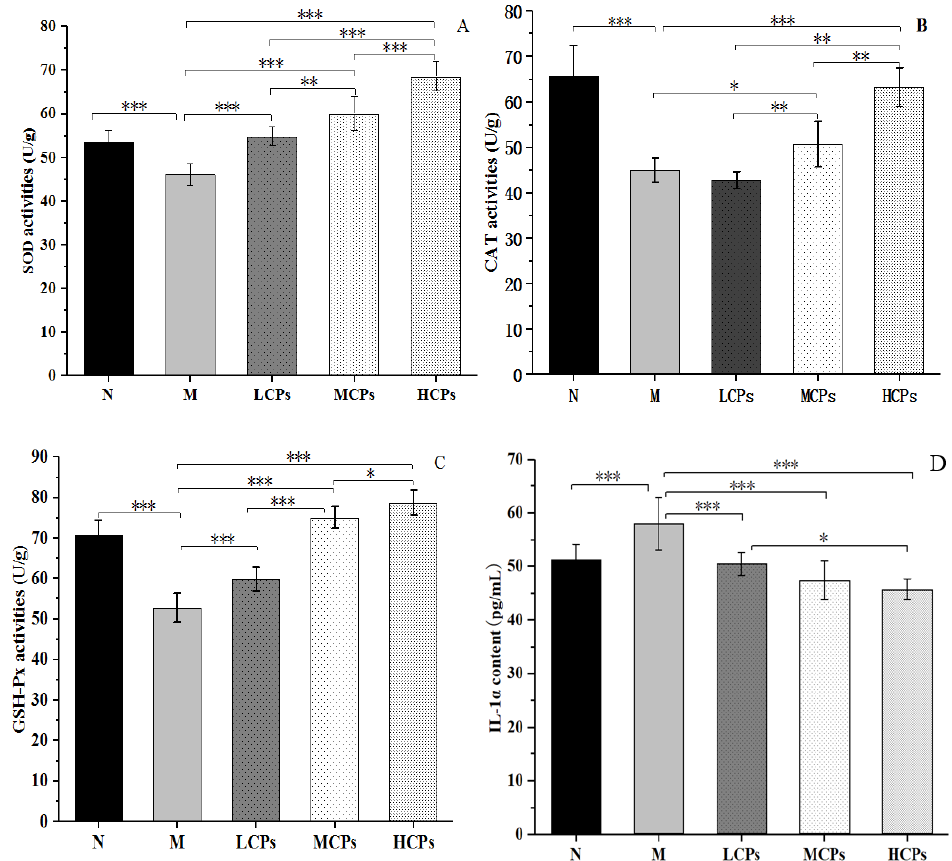
Figure 3. Effect of CPs on SOD ( A ), CAT ( B ), GSH-PX ( C ) activities and IL- 1α content ( D ) in the skin ( n = 10). Note: CP superoxide dismutase (SOD), glutathione peroxidase (GSH-PX), and catalase (CAT); *, ** and *** indicated that the data had statistically significant differences ( p < 0.05), very significant ( p < 0.01) and extremely significant ( p < 0.001),